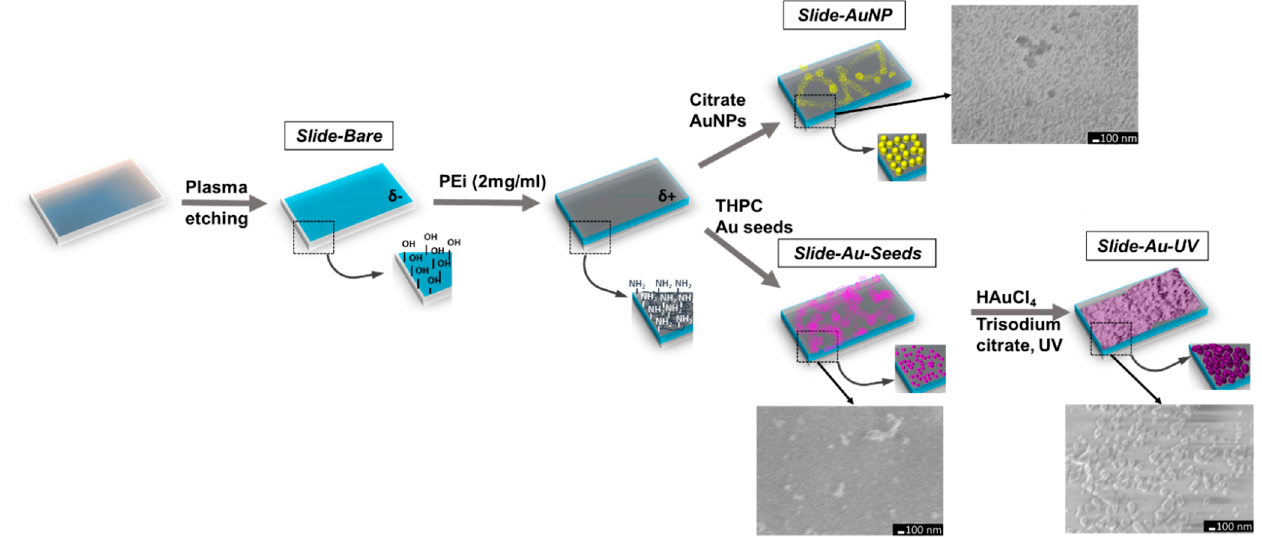
Figure 2. The fabrication process of SERS-active substrates on glass slides with scanning electron microscopy (SEM) images incorporated. The scale bar is 100 nm.